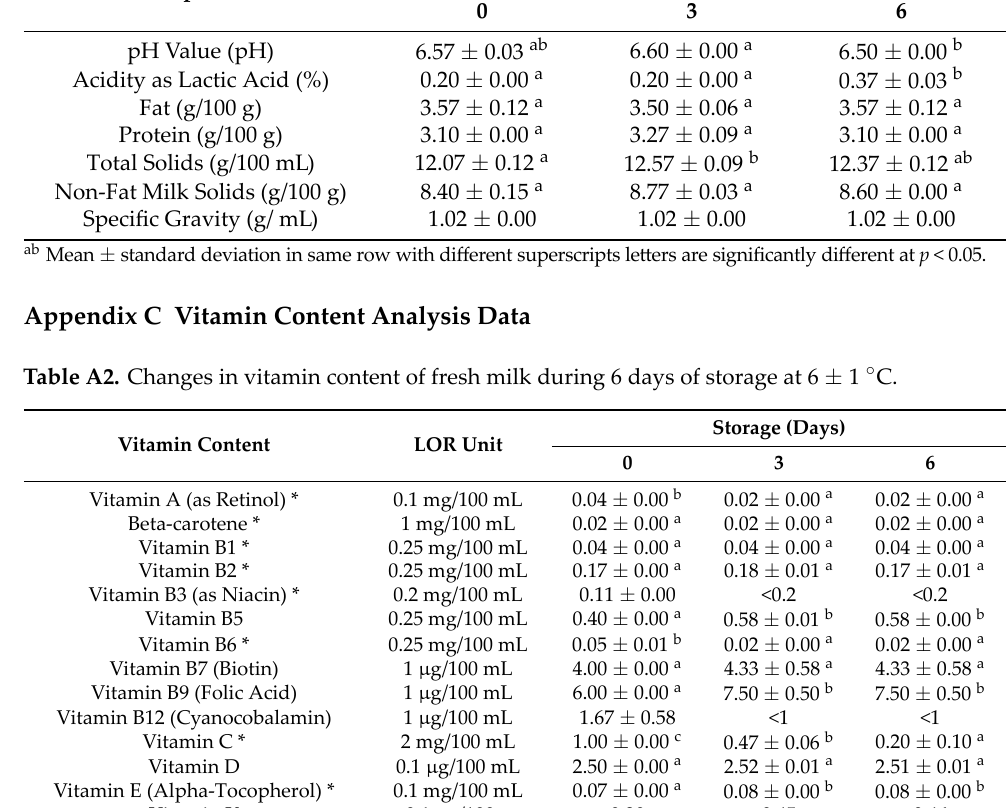
Table A1. Changes in physicochemical properties of fresh milk during 6 days of storage at 6 ± 1